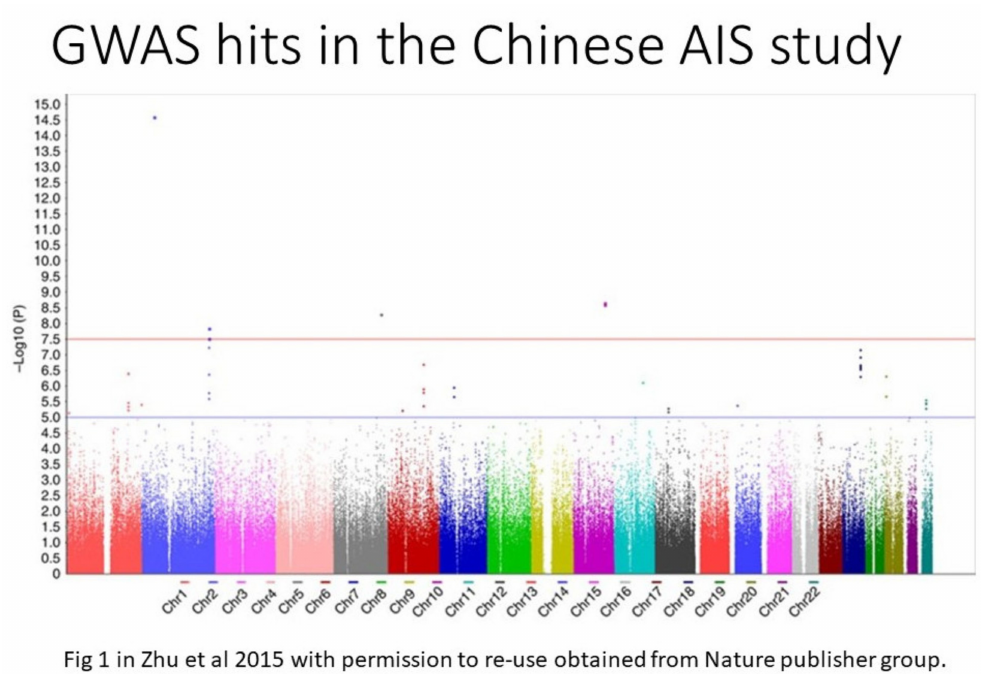
Figure 6. An example GWAS results in AIS showing putative predisposition SNPs and their statistical significance in a Manhattan plot from Chinese AIS GWAS study